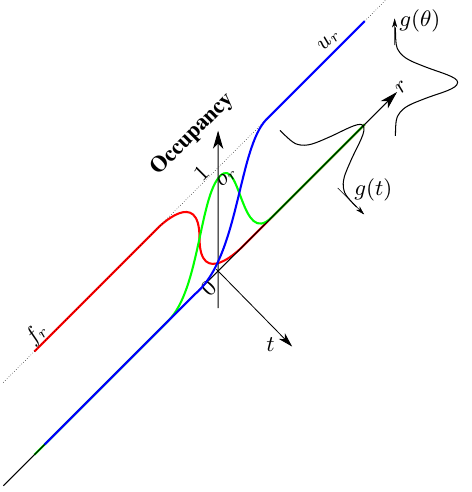
Figure 3. Occupancy in 3D considering uncertainties The occupancy in rotation θ and trajectory t directions is extrapo- lated using Gaussian functions g θ and g t . The standard deviations are determined by the gaps between rays in respective